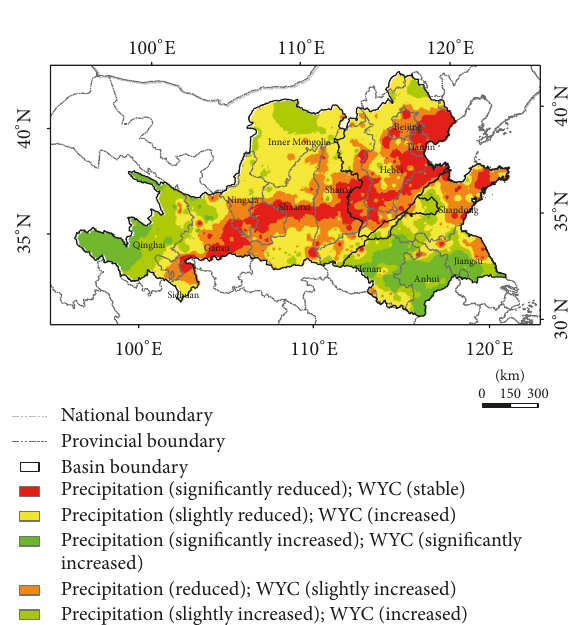
Figure 5: Cluster distribution.